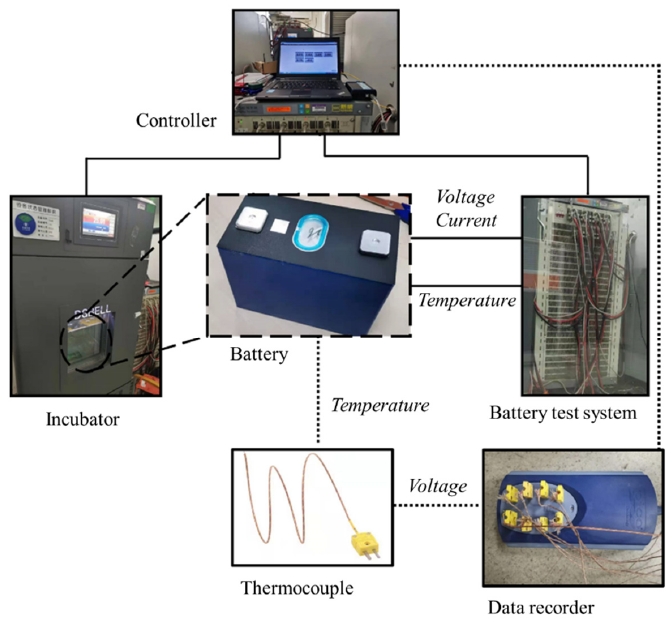
Figure 4. The configuration of the test bench.